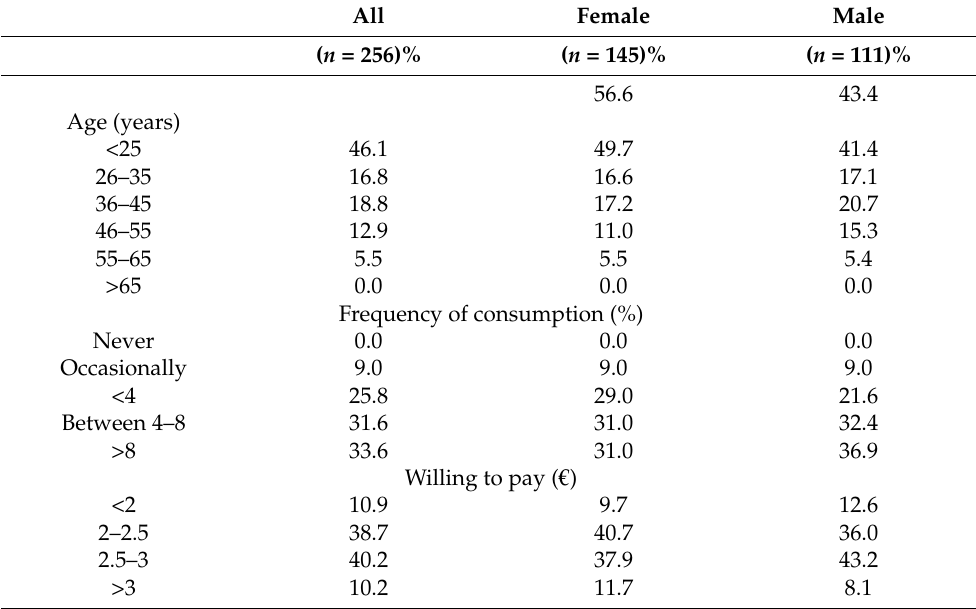
Table 5. Consumer’s profile ( n =